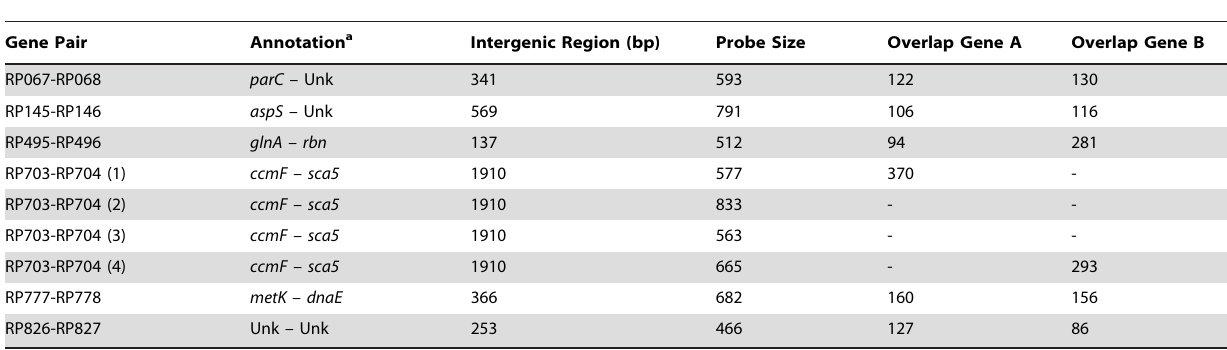
Table 2. Gene pairs and intergenic probes.